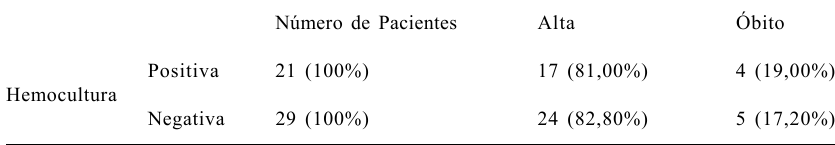
Tabela 4. Relação entre resultado da hemocultura e a mortalidade.**